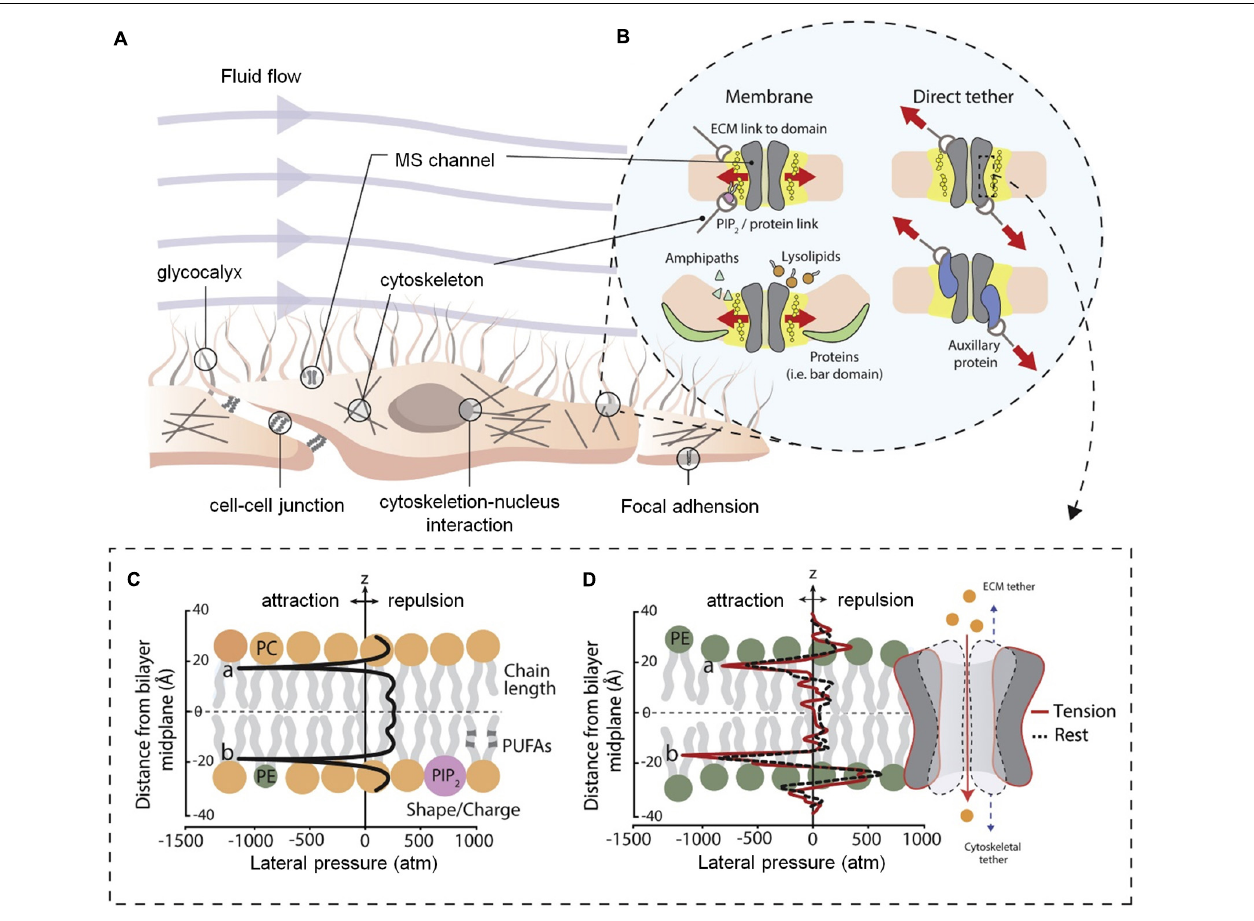
FIGURE 2 | Diagram of cell membrane and gating models for mechanosensitive ion channels (Cox et al., 2019). (A) Structure of mammalian cell environment. (B) Bilayer and direct tether models of mechanosensitive (MS) channel gating. (C) Ideal pressure curves for symmetric bilayers. The profile can be altered by the properties of the embedded membrane proteins and constituent lipid components. (D) Calculated the pressure distribution of 1-palmitoyl-2-oleoyl-sn-glycero-3-phosphoethanolamine (POPE) double-layer molecular dynamics simulation at rest and apply tension. Figures reproduced with permission from the references